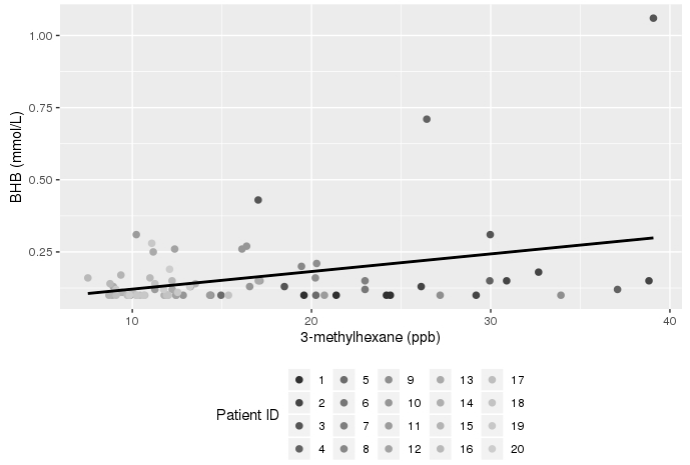
Figure 4. Scatter plot for breath 3-methylhexane vs. serum ketones (BHB). Dots with the same color shade belong to the same patient. Table 3. VOCs that correlate with serum ketone levels.